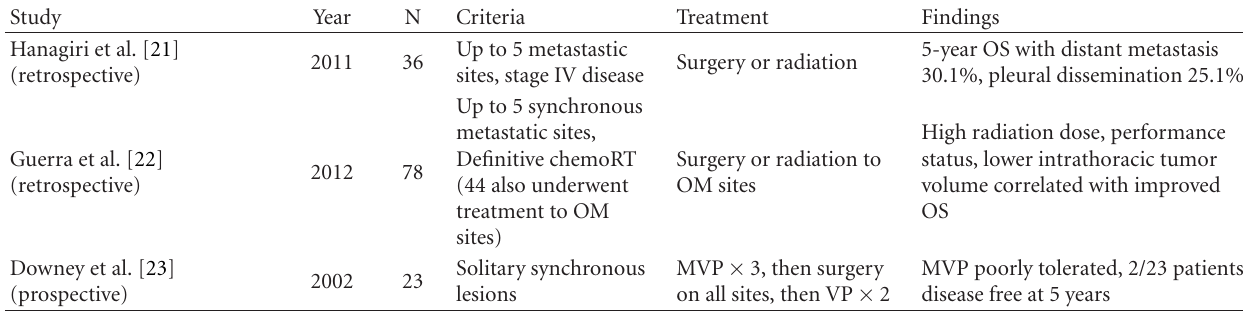
Table 2: Selected studies of local treatment in oligometastatic NSCLC with mixed metastatic